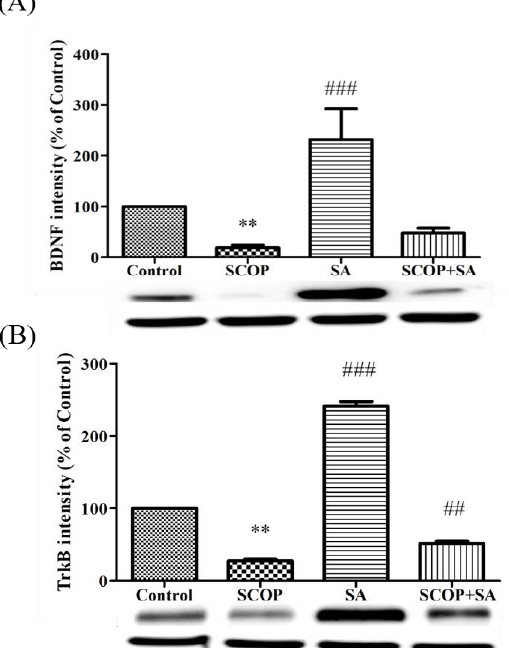
Figure 7. The effect of SA on the protein expression of BDNF and TrkB in SCOP-induced rat by western blot. ( A ) Representative image of immunoblotting and band quantification of BDNF/GAPDH. ( B ) Representative image of immunoblotting and band quantification of TrkB/GAPDH. All data showed as mean ± SEM. n = 4. ** p < 0.01 vs. the control group. ### p < 0.001, ## p < 0.01 vs. the scopolamine group. Analyzed by one-way ANOVA with LSD test.